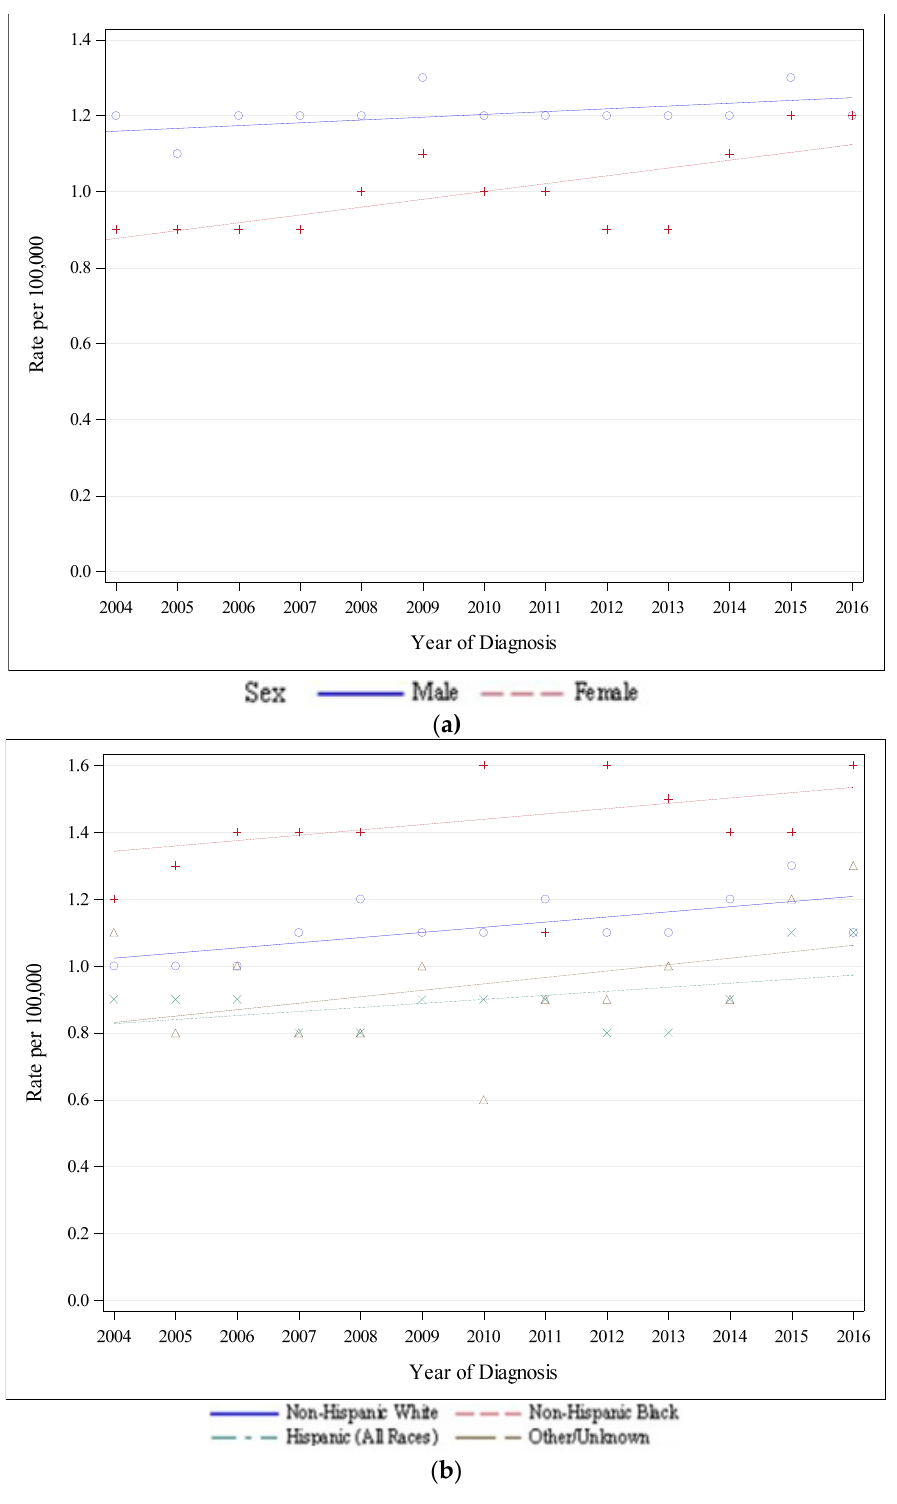
Figure 1. ( a ) Recent Trend in SEER-18 Age-Adjusted Incidence Rates by Sex, 2004–2016, all Races and Stages, Ages < 50, Delay-Adjusted Rate. ( b ) Recent Trend in SEER-18 Age-Adjusted Incidence Rates by Race/Ethnicity, 2004–2016, All Sexes and Stages, Ages < 50, Delay-Adjusted Rate. Figure 1. ( a ): Recent Trend in SEER-18 Age-Adjusted Incidence Rates by Sex, 2004–2016, all Figure 2a,b show trends in the percentage of diagnoses by stage at presentation and Races and Stages, Ages <50, Delay-Adjusted Rate. ( b ): Recent Trend in SEER-18 Age-Adjusted race/ethnicity, respectively. Diagnoses of distant-stage disease represented the highest Incidence Rates by Race/Ethnicity, 2004–2016, All Sexes and Stages, Ages <50, Delay-Adjusted percentage of diagnoses among all years in the study period, while localized-stage Rate